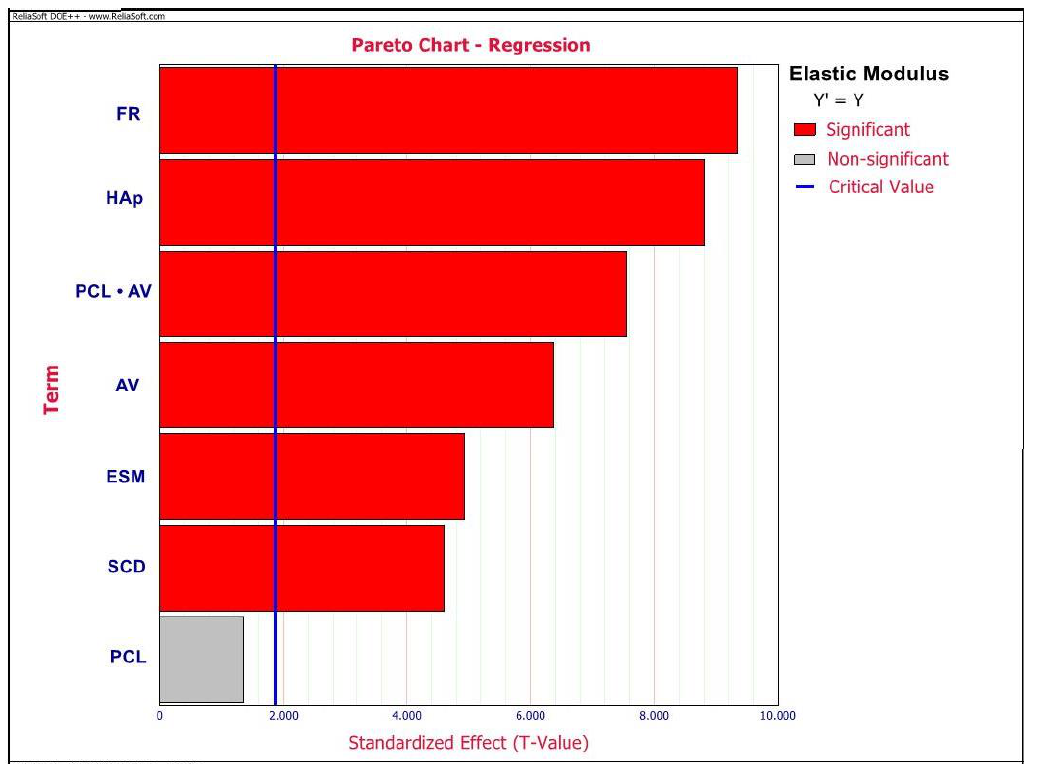
Figure 2. Pareto chart depicting the significant factors affecting elastic modulus values of an elec- trospun composite membrane.